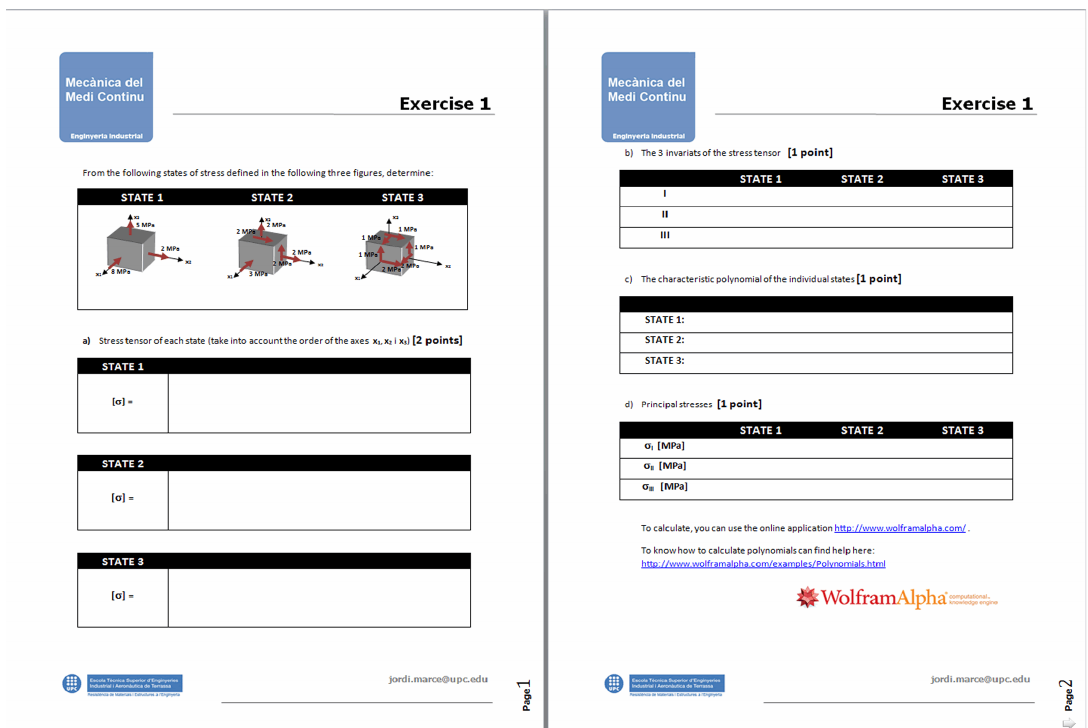
Figure 2. Worksheet of Exercise 1 with the blanks to be filled in with the